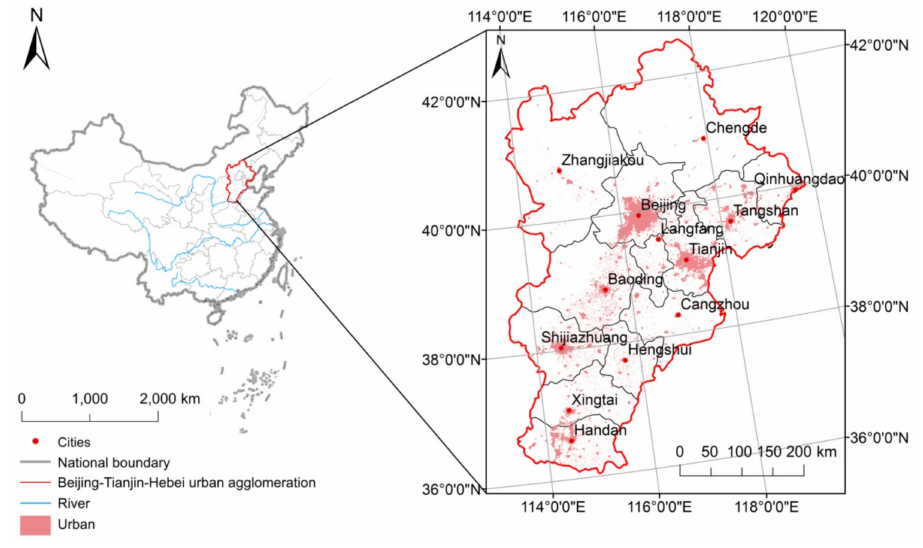
Figure 1. The study